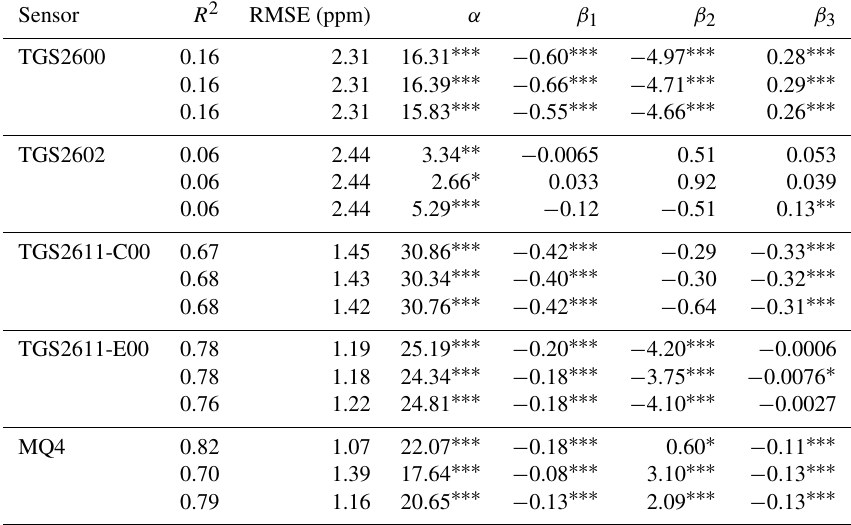
Table 3. Regression performance and coefficients for Eq. (2) CH 4 = α + β 1 ( sensor resistance ) + β 2 ( H 2 O ) + β 3 ( H 2 O )( sensor resistance ) + ε , with CH 4 in ppm, H 2 O as percent, and sensor resistance in k (cid:127) . Every cell shows values for each of the three replicates of the given sensor. Sensor R 2 RMSE (ppm) α β 1 β 2 β 3